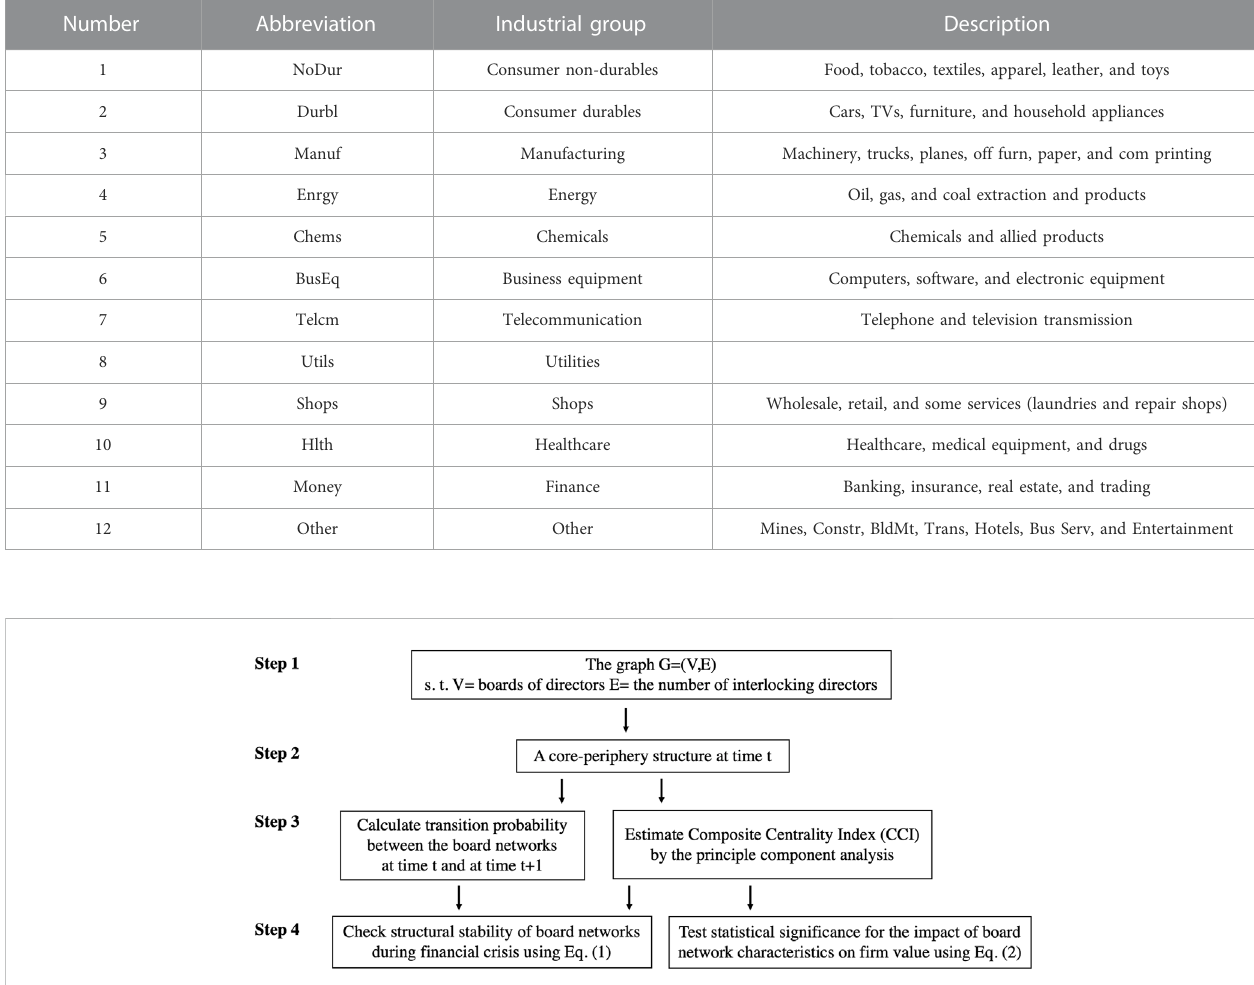
FIGURE 1 Schematic diagram. We construct board networks by interlocking directorates and investigate a core – periphery structure from 2000 to 2015. The structural stability is calculated by Eq. 1, and the impact of centrality from the board network on the fi rm value is estimated by Eq.